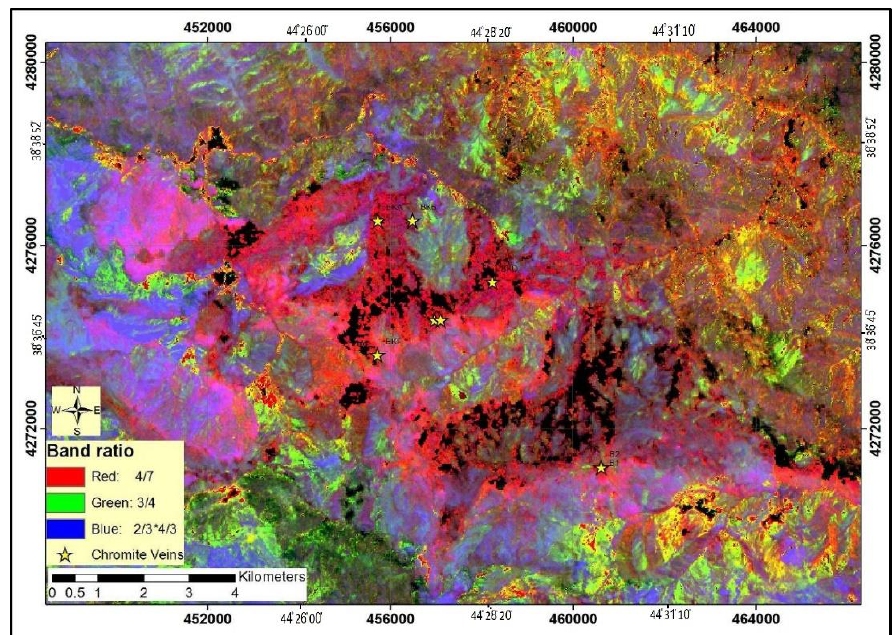
pillow lava; csl—shale and conglomerate.